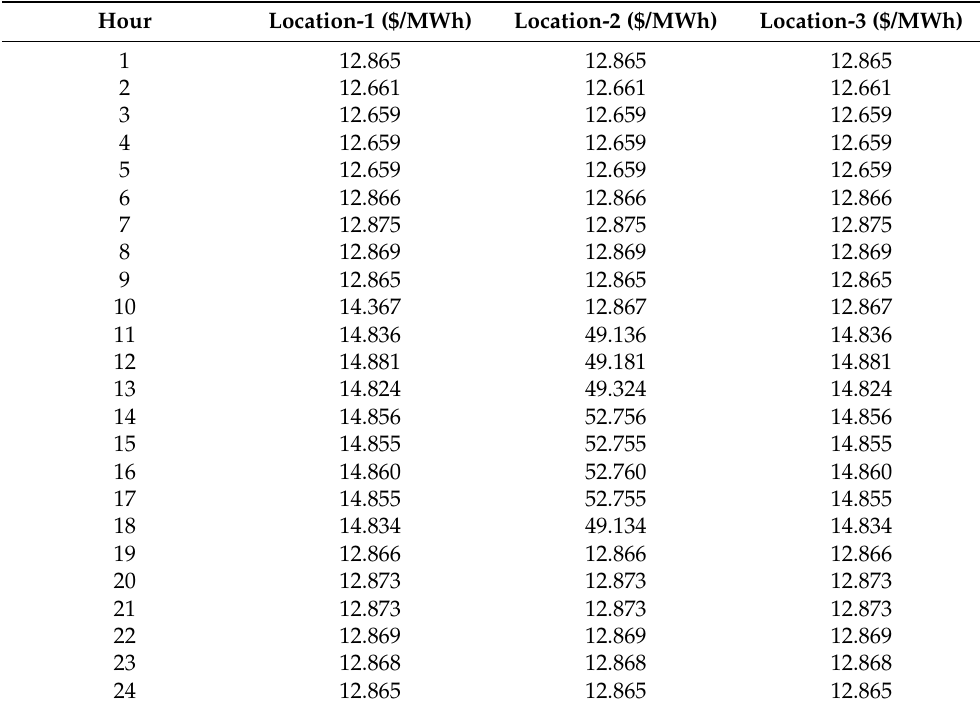
Table 7. LCP Analysis Results at 3